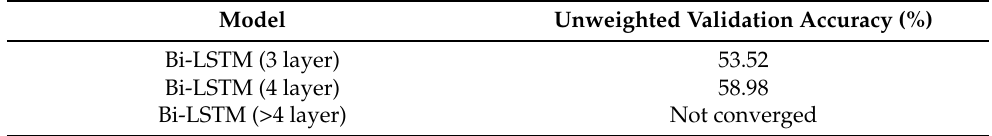
Table 3. Comparison of the student model with different layer